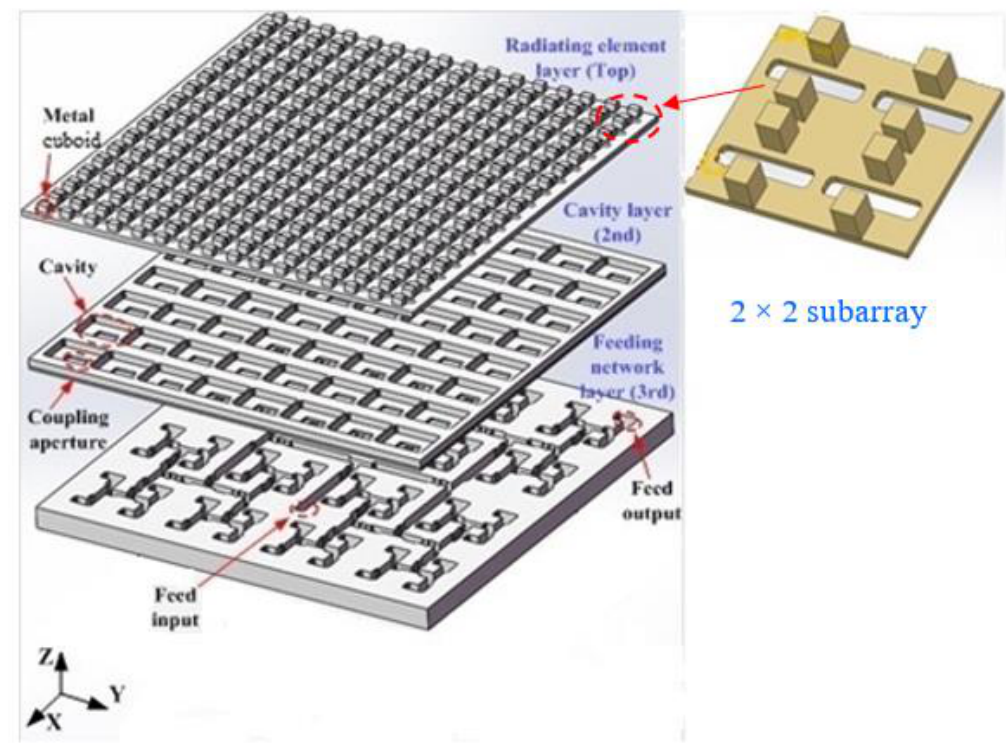
Figure 1. Expanded perspective view of the 16 × 16 complementary dipole antenna array.